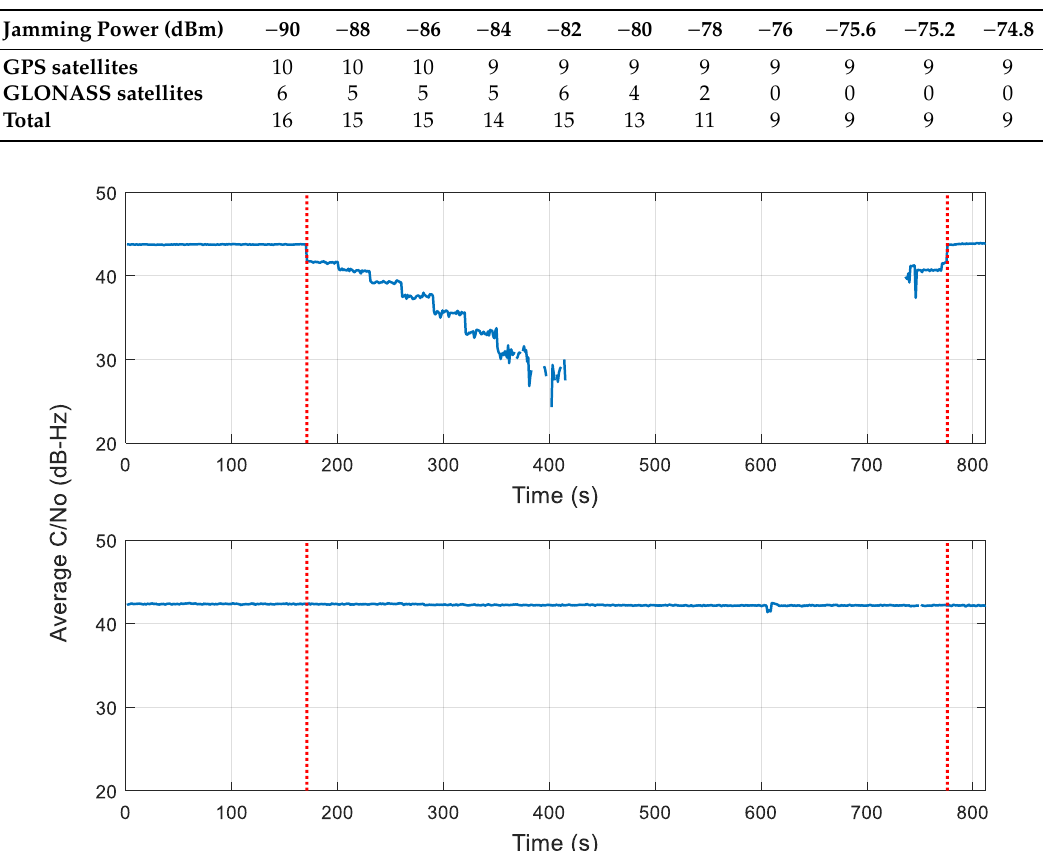
Table 8. Minimum number of available satellites for scenario #6.